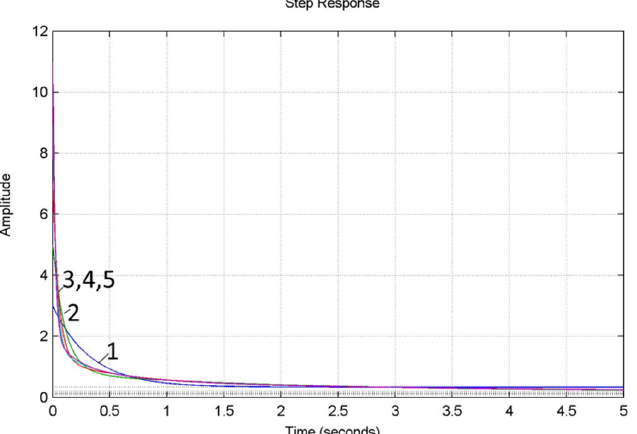
Figure 2. Frequency characteristics of parts (12)—1, (15)—2, (20)—3, (21)—4, (22)—5. Similarly, the graphs of the transition functions of theI λ parts ( α = λ = − 0.5), which are described by the TFs (13), (16), (23)–(25) (Figure 3), and the frequency characteristics of these TFs (Figure 4) were obtained.